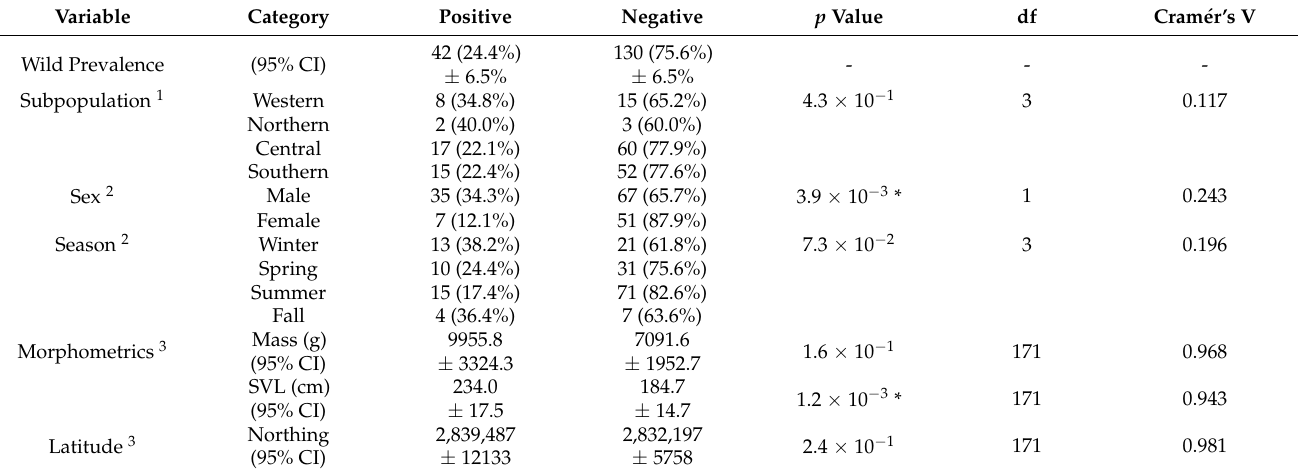
Table 3. Epidemiological data from 172 wild southern Florida, USA Burmese pythons sampled for serpentovirus via reverse transcription PCR (rtPCR). For continuous variables, 95% confidence intervals (95% CI) are